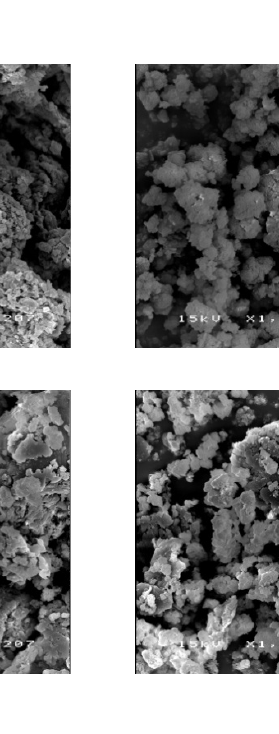
composites: a) 50:1dPPP at 1000x; b) ZSM-5(23) at 1500x; c) 50:1dPPP(90)/NaZ23